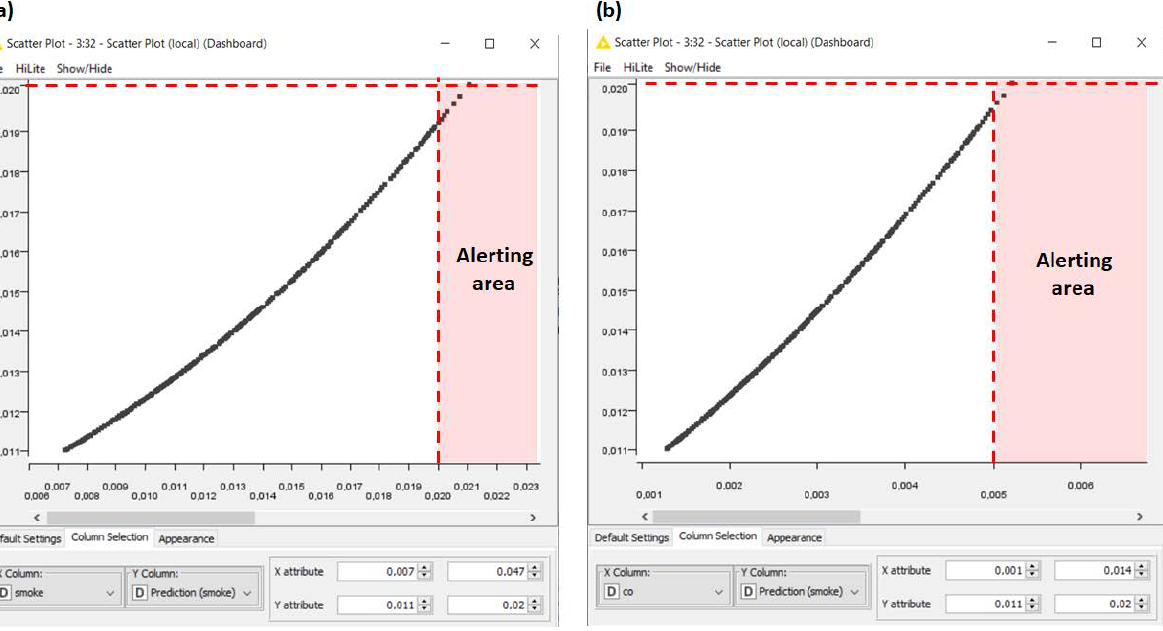
Figure 7. KNIME ANN-MLP algorithm predicting smoke variable. Plots of smoke versus predicted smoke ( a ), and co versus predicted smoke ( b ). The red area represents the alerting condition. Table 2. Alerting conditions as results of the check of thresholds and of the ANN-MLP predicted